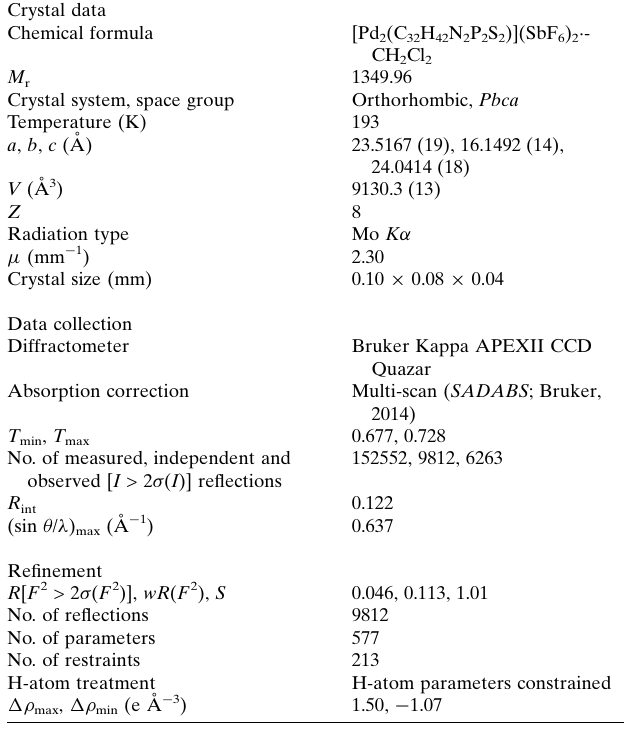
Table 2 Hydrogen-bond geometry (A˚ , (cid:3)